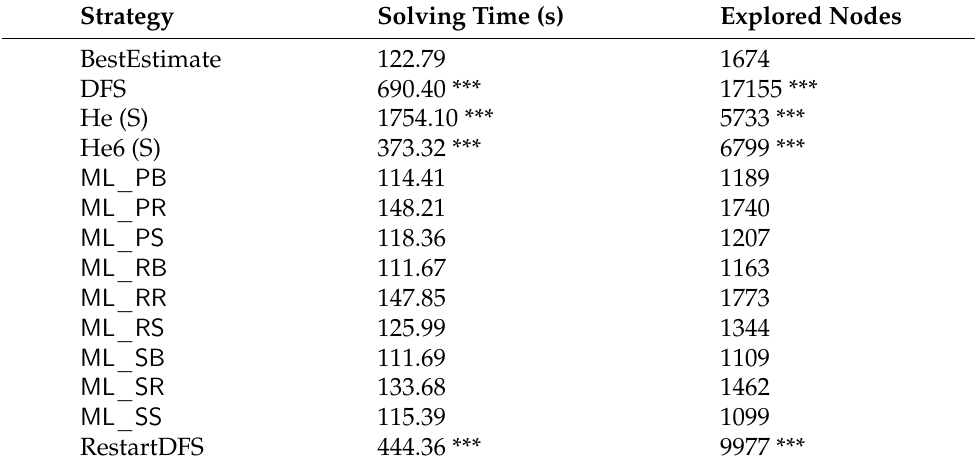
Table A3. Capacitated facility location instances: average solving time and explored nodes